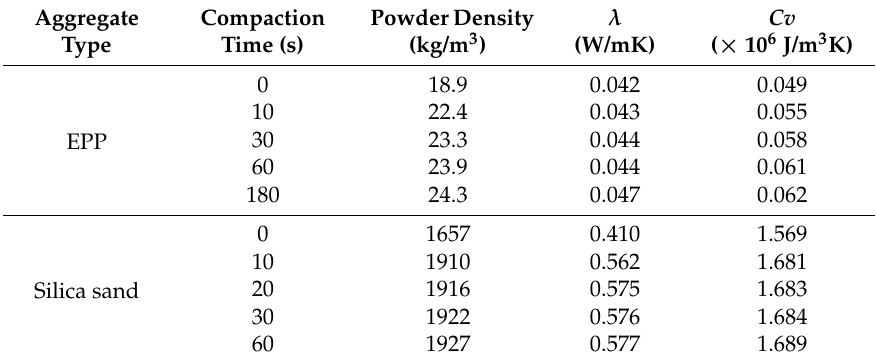
Table 4. Thermophysical properties of aggregates with dependence on the compaction time.